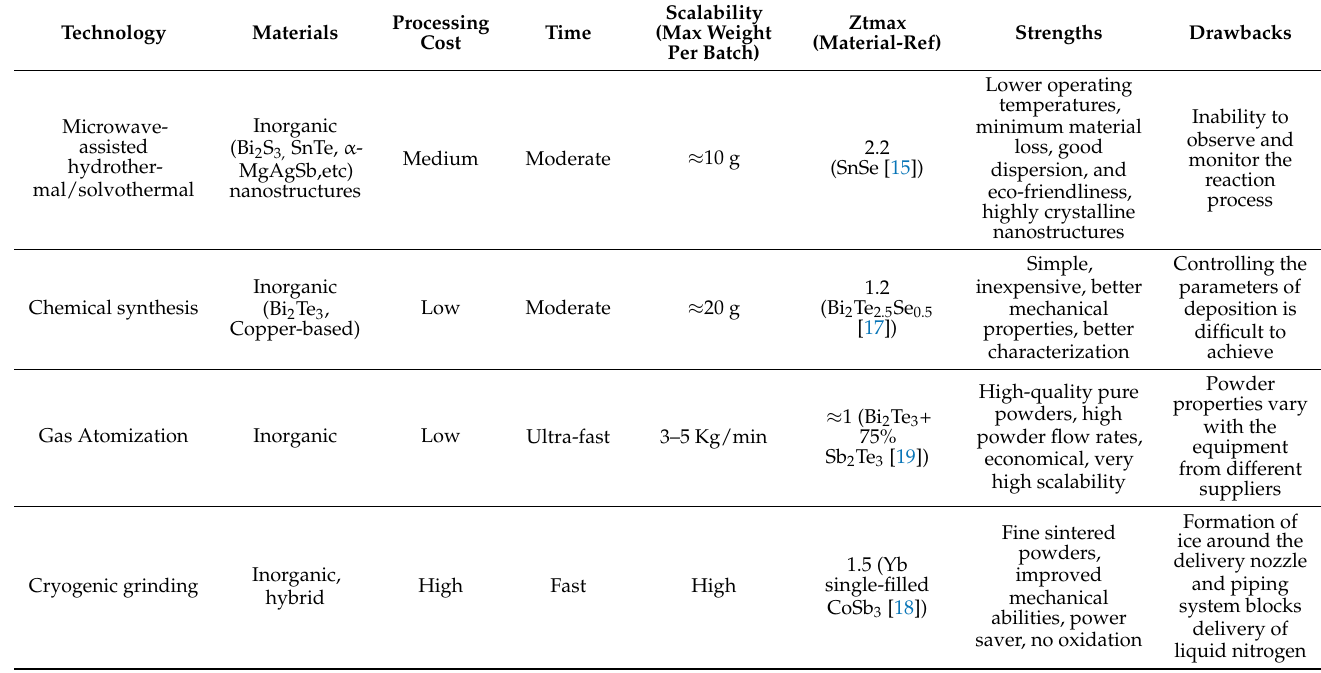
Table 1. Summary of recent progress in prominent large-scale synthesis methods.